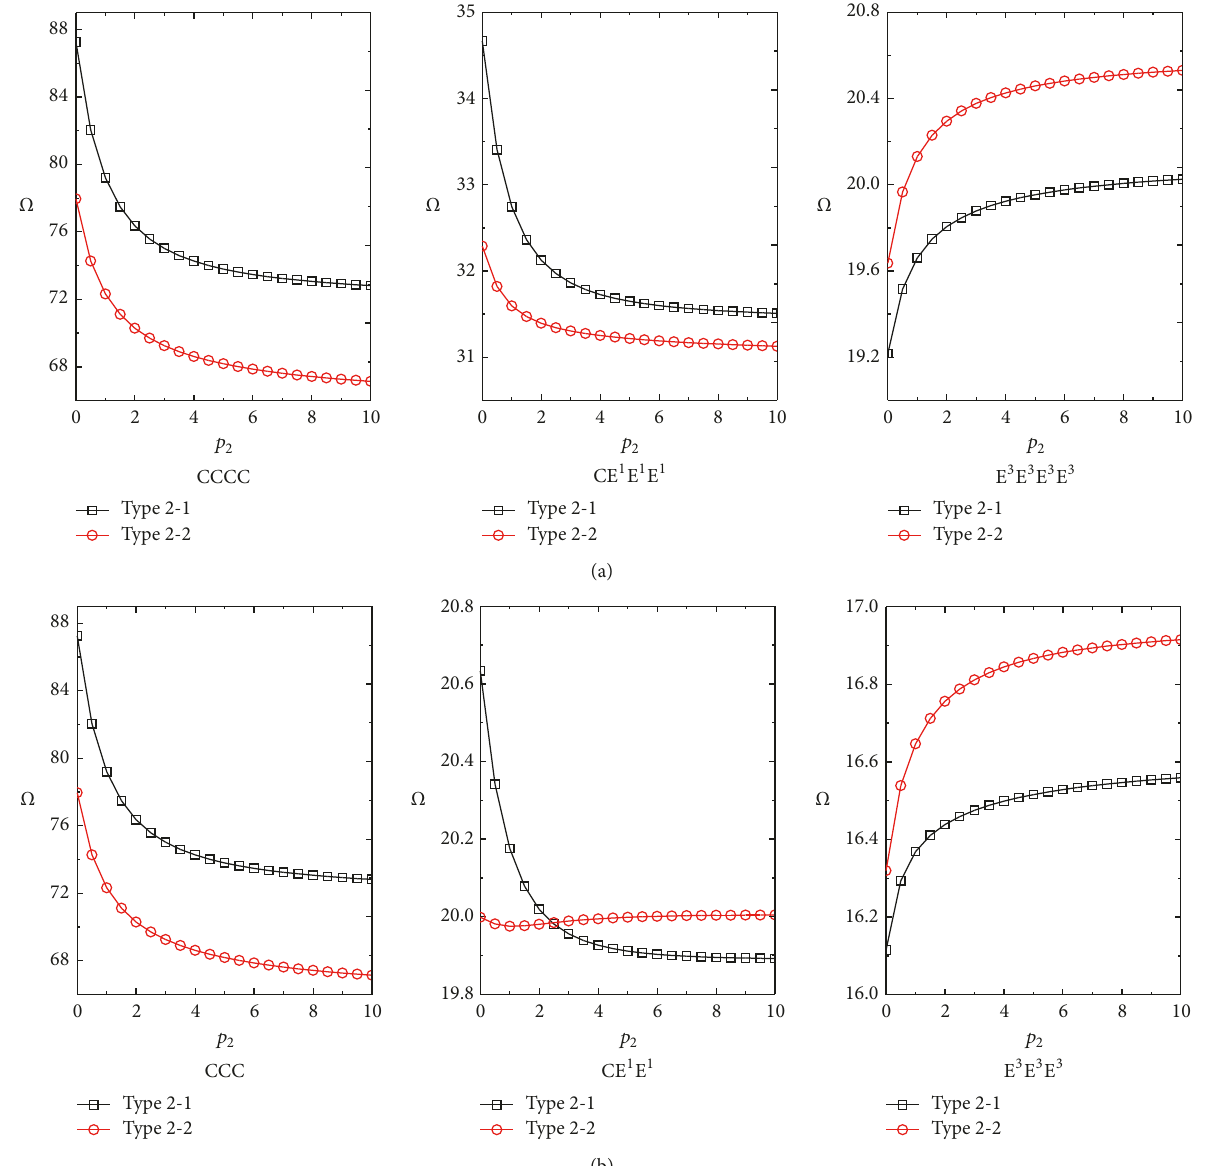
Figure 10: Variations of fundamental frequency parameter Ω of Type 2 (2-2-1) sector plate against different power-law exponents: (a) annular sector plate; (b) circular sector